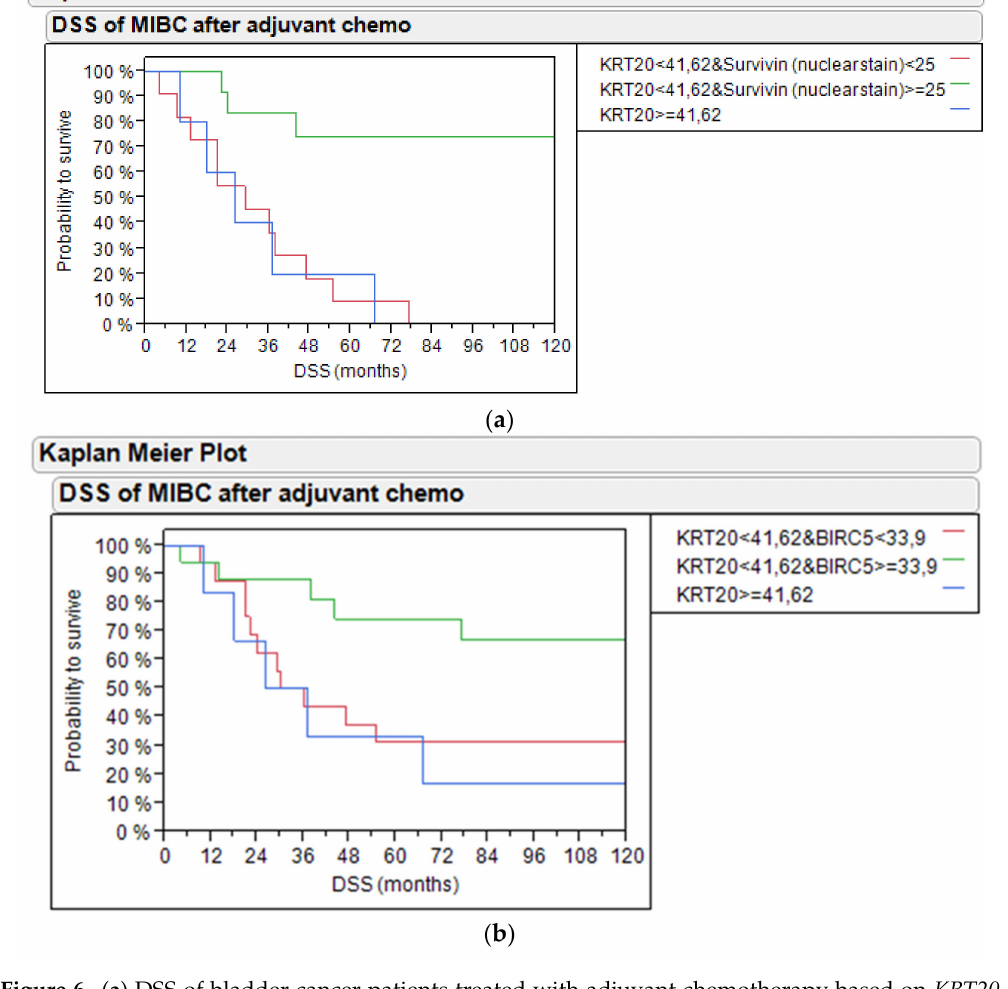
Figure 6. ( a ) DSS of bladder cancer patients treated with adjuvant chemotherapy based on KRT20 mRNA and survivin nuclear protein stain in the PCR and IHC cohort; ( b ) DSS of bladder cancer patients treated with adjuvant chemotherapy based on KRT20 and BIRC5 mRNA expression in the PCR cohort. Multivariate cox proportional hazard analysis of DSS revealed that the combination of BIRC5 and KRT20 mRNA to predict outcome was an independent prognostic factor, when age, sex, BMI, tumor stage, grade, and node status were included in the analysis ( p = 0.0167, Table